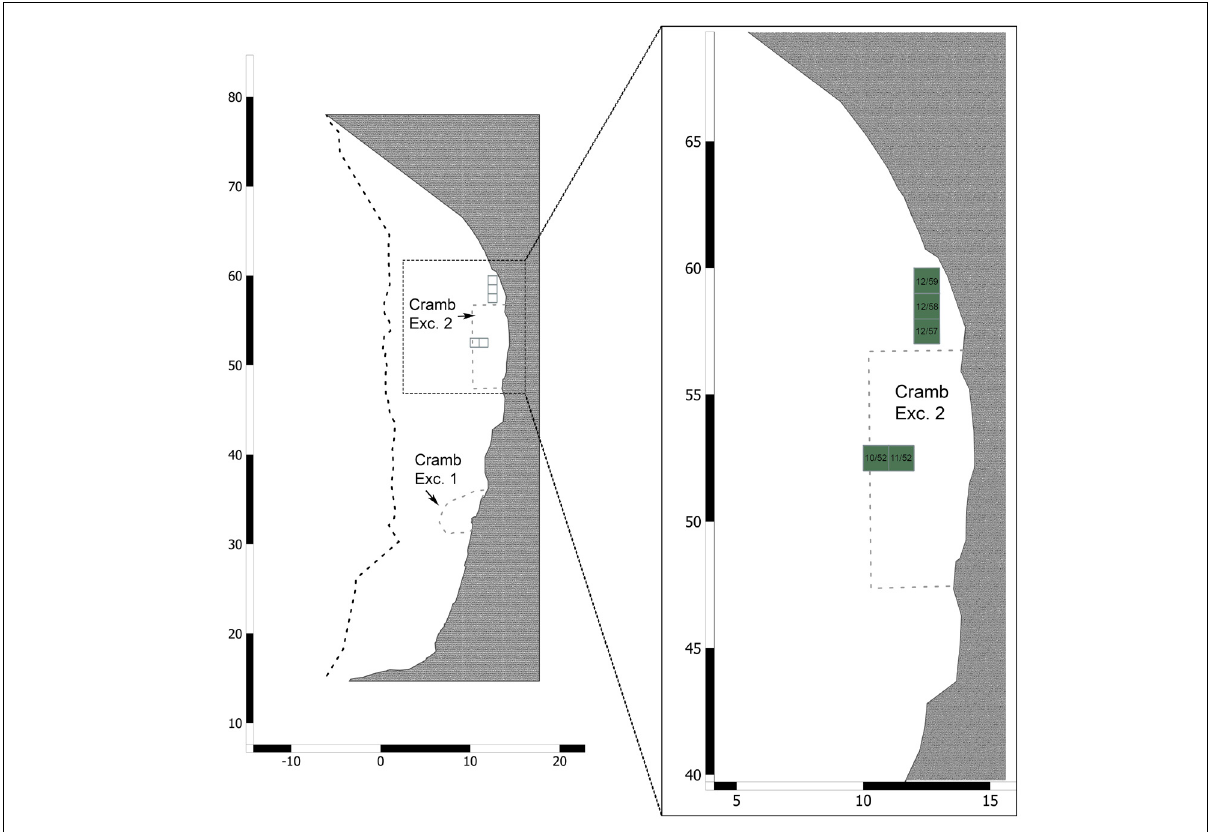
Figure 2: Excavation plan of Holley Shelter. Cramb Exc. 1 and 2 mark the areas of Cramb’s excavations in the 1950s. Exc. 1 = ‘smaller habitable area’, Exc. 2 = ‘larger habitable area’. Green squares were excavated by the TSAARU team in 2022. Figure by G.